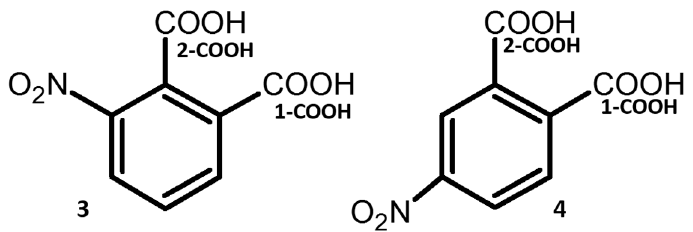
Figure 1. Chemical structures of 3-nitrophthalic ( 3 ) and 4-nitrophthalic ( 4 ) acids.